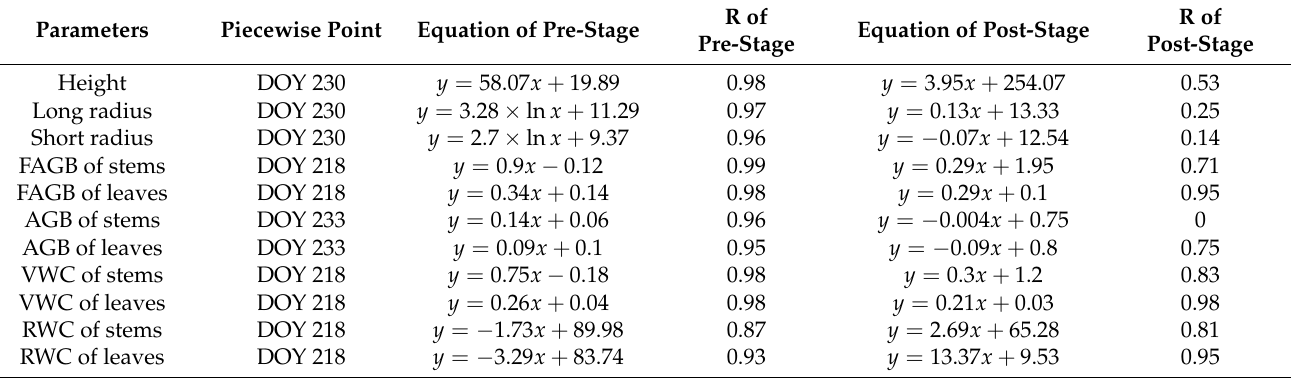
Table 2. The piecewise points of the maize canopy parameters for the entire growing season corre- sponding to the DOY and the fitted equations at the two growth